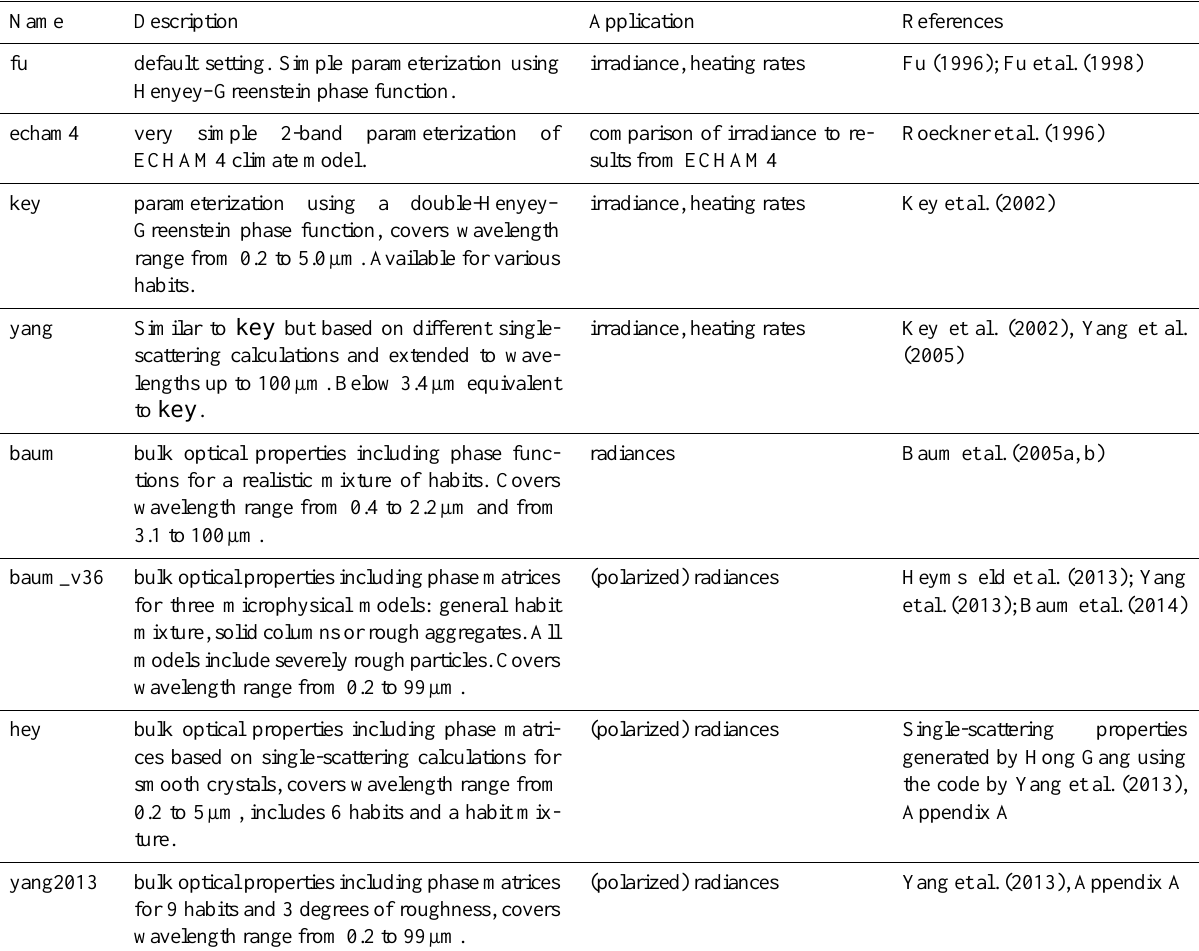
Table 5. Ice cloud parameterizations in